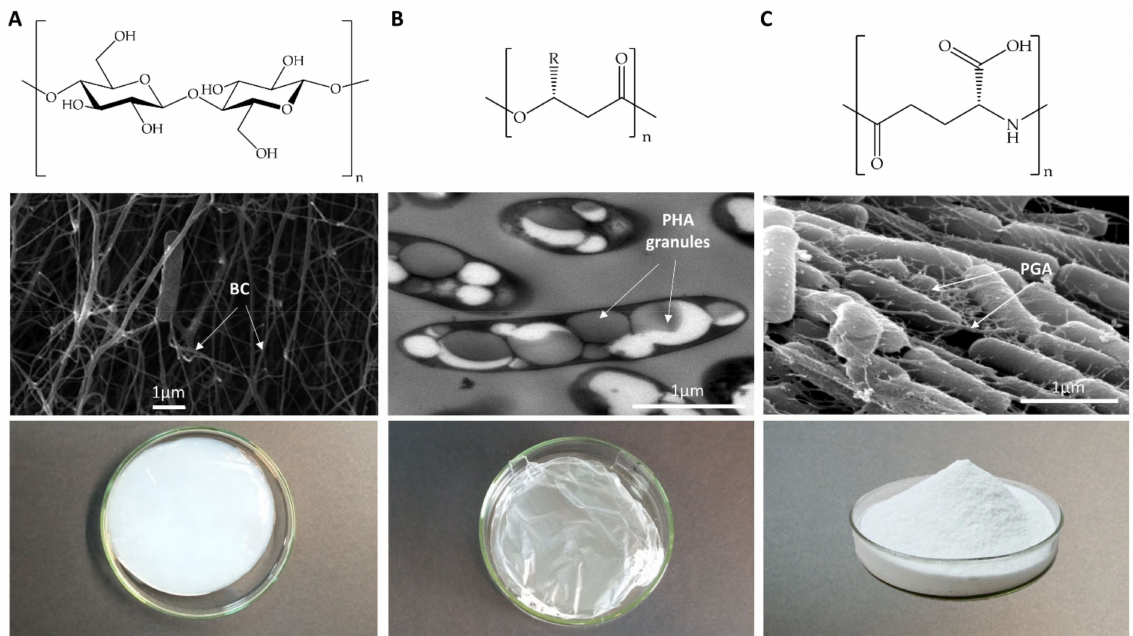
Figure 1. Chemical, microscopic, and macroscopic structure of BC, PHA, and PGA produced by model bacteria Koma- gataeibacter medellinensis , Pseudomonas putida , and Bacillus subtilis . Upper panels represent the chemical polymer structure, middle panels show electron microscopy images of the microorganisms producing the polymer, and lower panels show the macroscopic appearance of the purified polymer of BC ( A ), PHA ( B ), or PGA ( C ). SEM images of K. medellinensis and B. subtilis . Reprinted with permission from [14,15]; Copyright Microbiology Society, 2013,